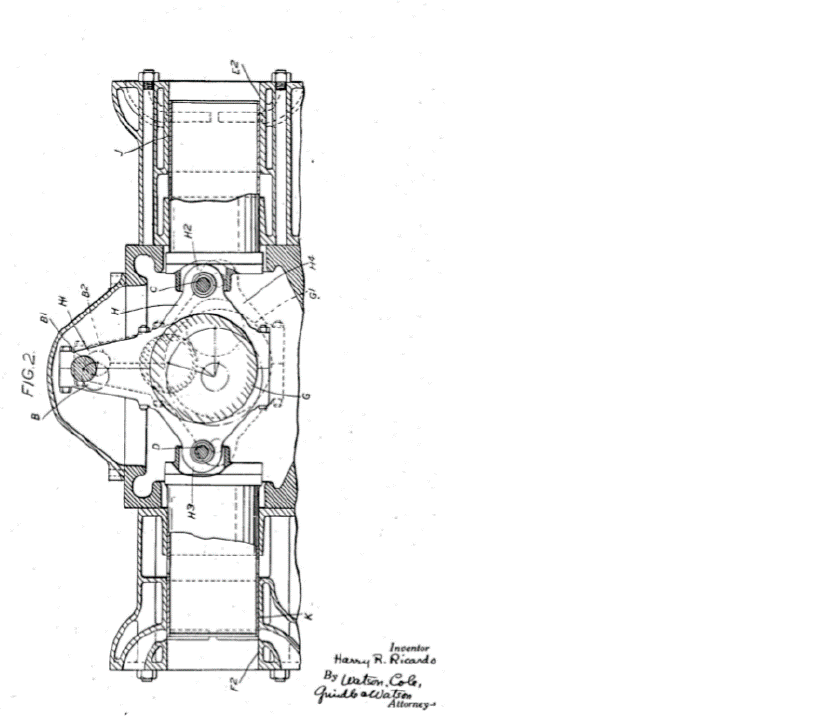
Figure 13. H Ricardo 11 June 1943, Two stroke sleeve valve engine US 2367963. Reproduced with